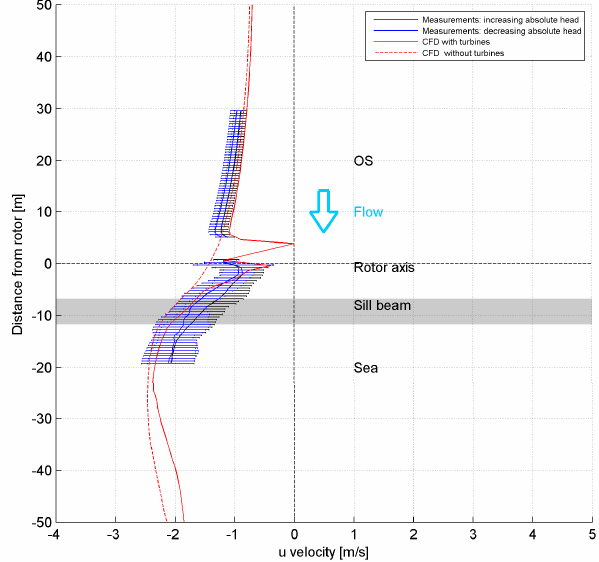
Fig. 9 Longitudinal ADCP profile from the measurements with turbines (in blue) and the CFD (in red) – Ebb Case WT.1Fig. 8 Vertical ADCP profile from the measurements without